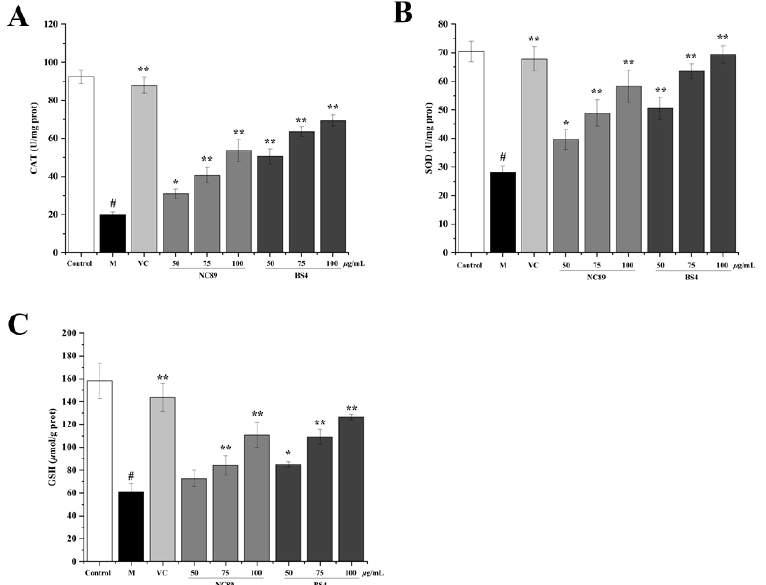
Figure 5. NC89 and BS4 tobacco seed oils enhanced intracellular antioxidant defense enzyme activities in H 2 O 2 -induced HepG2 cells. The content of cellular CAT( A ), SOD( B ), and GSH( C ) were determined by commercially available kit. Values are presented as the mean ± SD ( n = 3). # p < 0.05 vs. Control group; * p < 0.05, ** p < 0.01 vs. M group.